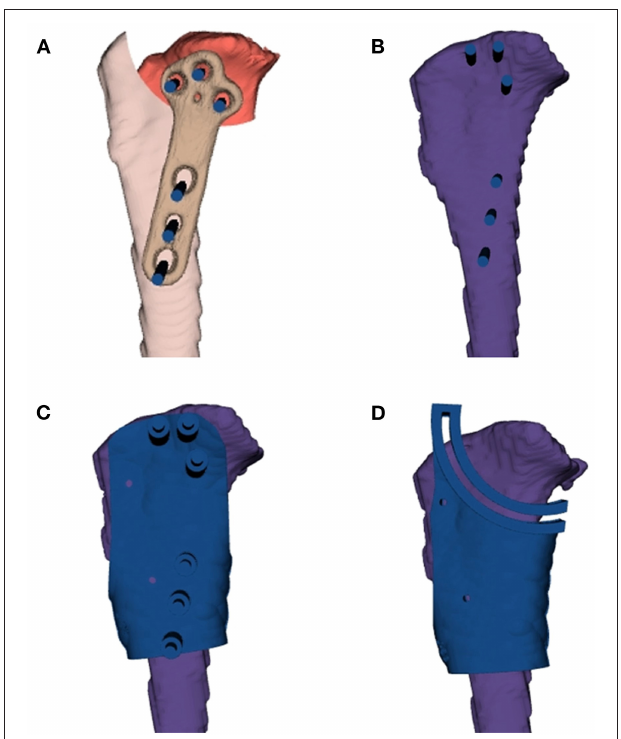
FIGURE 1 | Medial aspect of the virtual tibia model for the customized three-dimensional printing surgical guide design. (A) The proximal tibial plateau segment is virtually rotated. (B) A TPLO plate is placed and a virtual trajectory is created according to the screw insertion direction. (C) The rotated proximal tibial plateau segment is placed back, and a drill guide template is created corresponding to the screw trajectory. (D) A saw guide template is created with the diameter based on the preoperative planning. TPLO, tibial plateau leveling osteotomy.